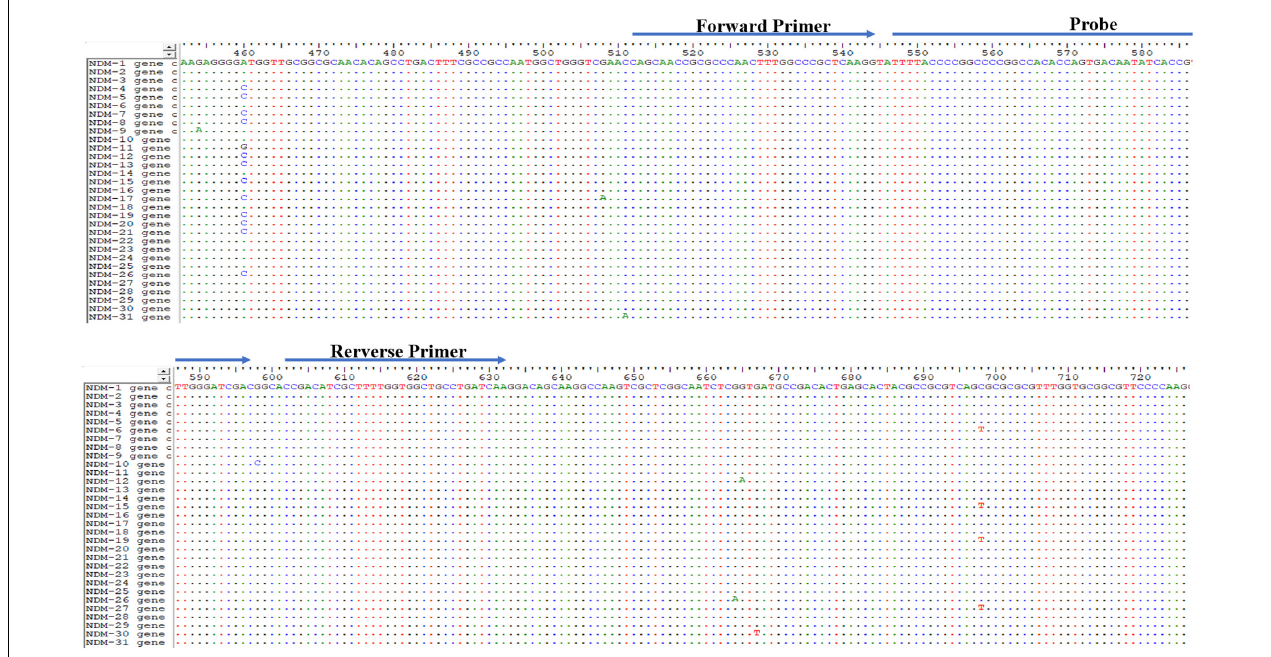
FIGURE 1 | Primer and probe regions in the 31 bla NDM variants.